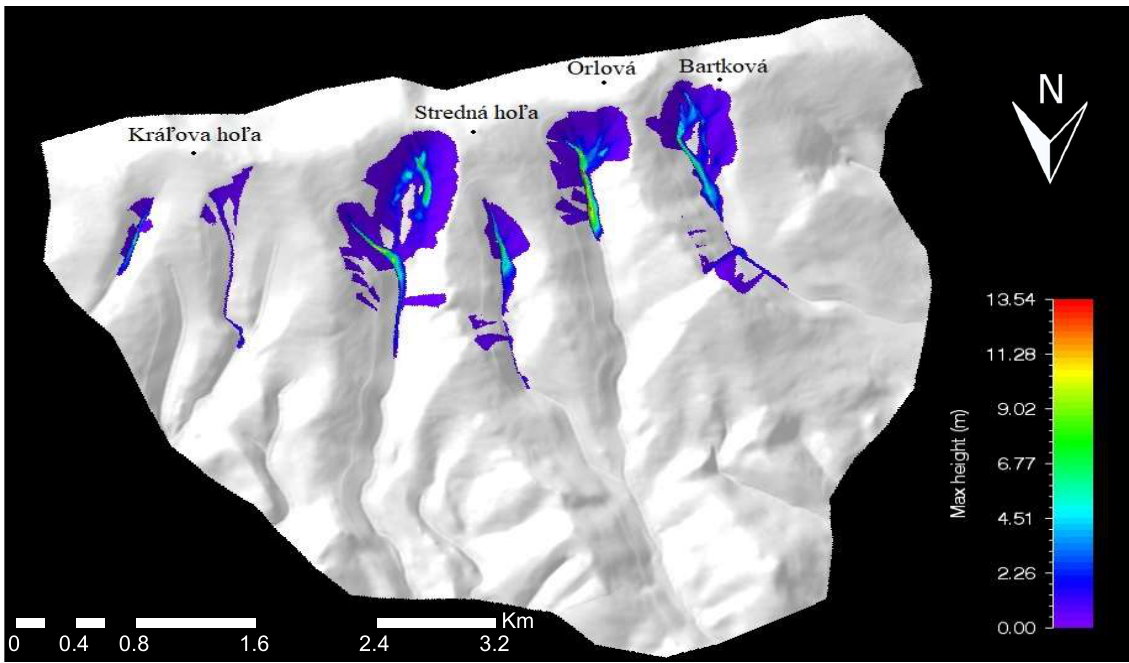
Figure 7. Maximum snow flow height (northern slope).